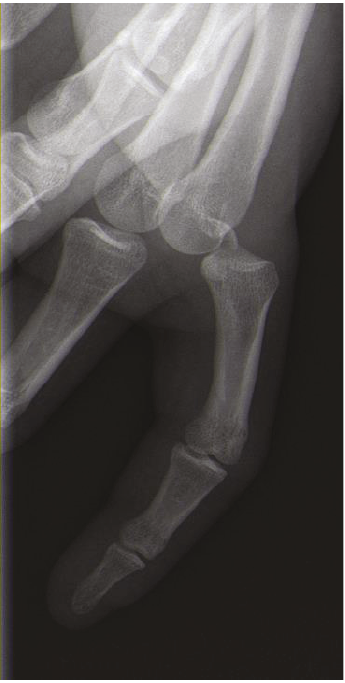
Figure 3: X-Ray (lateral view) showing MCP dislocation of the index fi nger with a small dorsal osteochondral fragment.